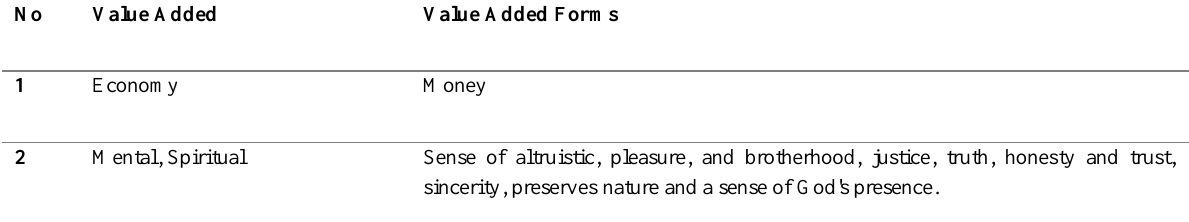
Table 1: The forms of kaamilah sharia value added with the Qur'anic